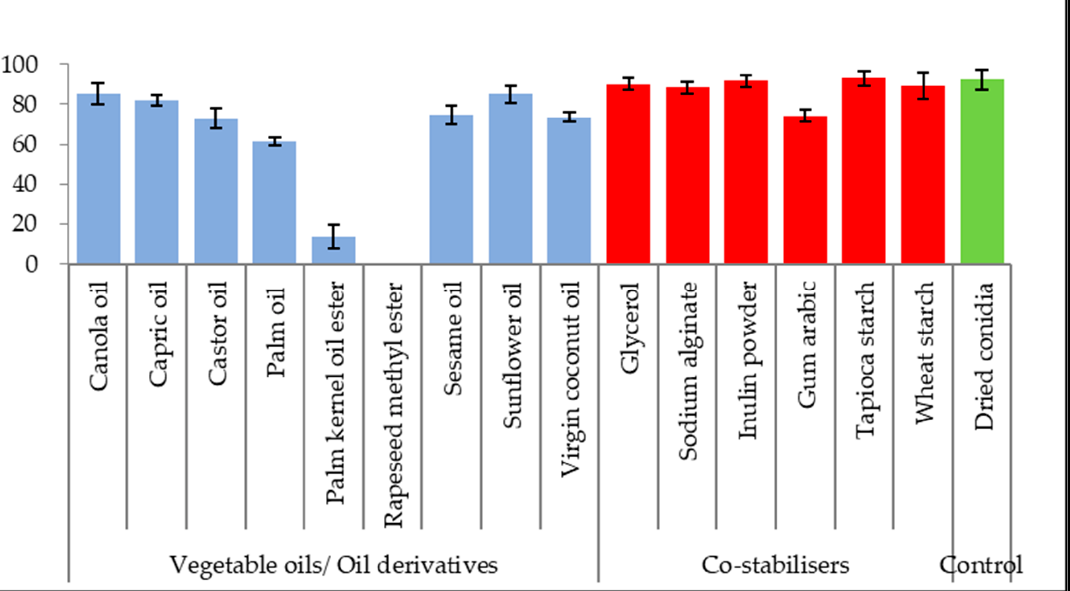
Figure 1. Conidial viability of M. anisopliae (strain Met-Gra4) suspended in 100% oils and aqueous mixture of co-stabilizers. Data are expressed as mean ± standard deviation ( n = 3). Based on the screening of nine non-ionic surfactants on dry-harvested conidia (Figure 2), Levene’s test of equality of error variances indicated sufficient evidence to claim that the variances were equal across groups ( F 0.05,26,54 = 2.529, p = 0.02) Data showed a significant difference among the three concentrations ( p < 0.005). Negative control using